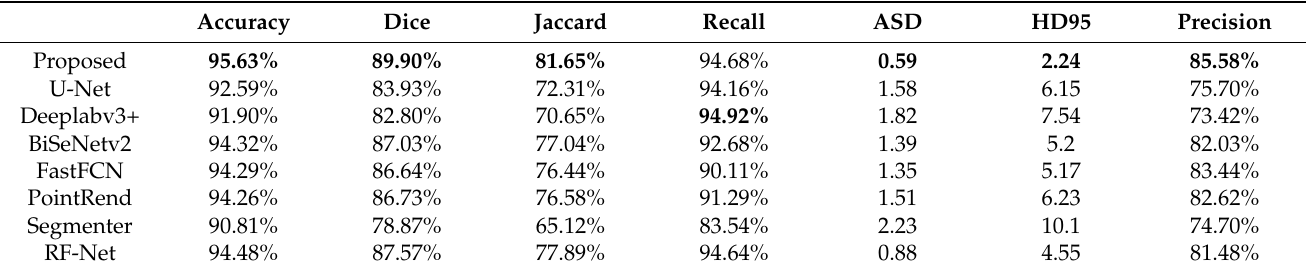
Table 5. Evaluation results of the compared methods. Bold means the best value.